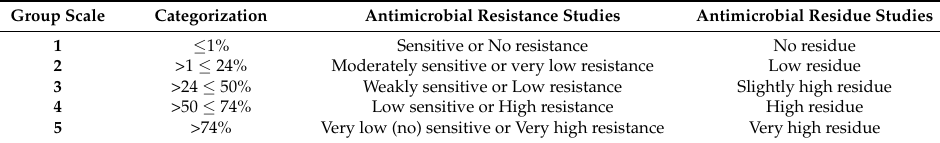
Table 2: This is a table showing the scale developed to measure the level of resistance or residue in a harmonized form from different diverse measurements from the several studies. Percentage referred to the proportion of resistant microbe populations (species) per